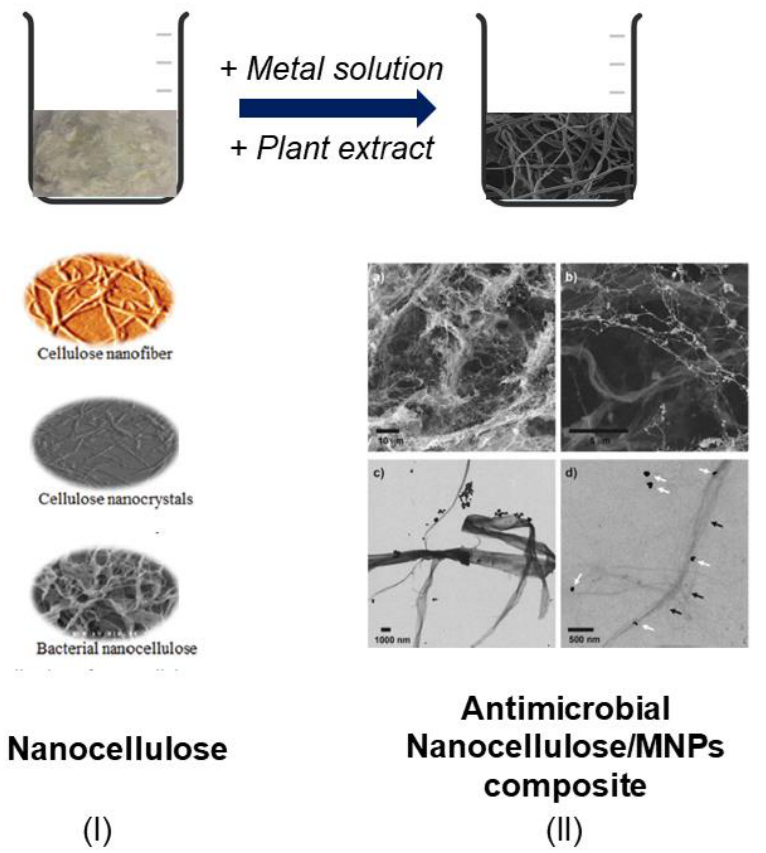
Figure 4. Illustrative presentation of green synthesis of nanocellulose/metal or metal oxide hybrid nanocomposites. ( I ) Different types of nanocellulose in dispersion; ( II ) Electron microscope images of MNPs in cellulose ( a and b for SEM images, and c and d for TEM images, respectively): white and black arrows point to MNPs and defibrillated cellulose, respectively (Adapted from [107,118] with permission from The Royal Society of Chemistry and Scientific Reports).